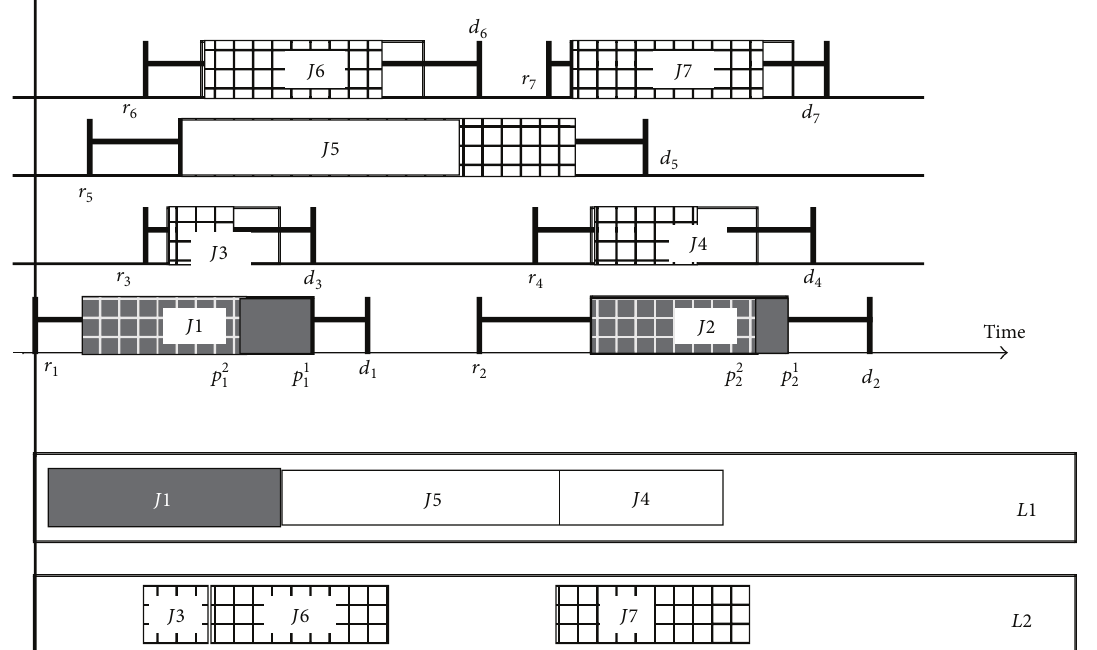
Figure 1: An illustration of the cable parallel production lines scheduling